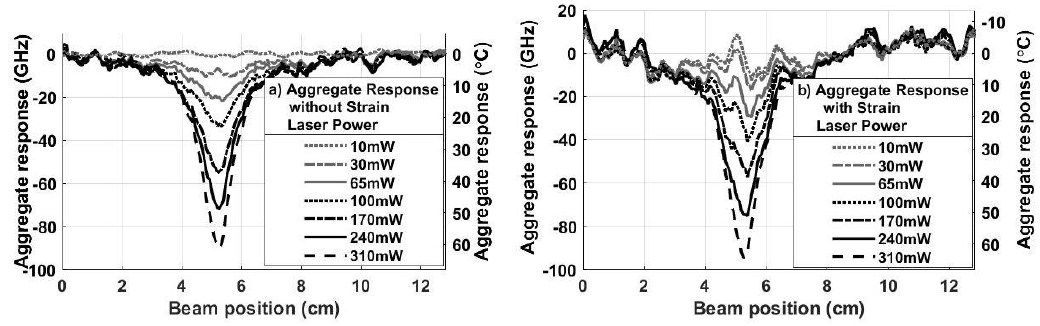
Figure 13. Plots of the aggregate response at each optical power level: ( a ) without strain, and ( b ) with strain.